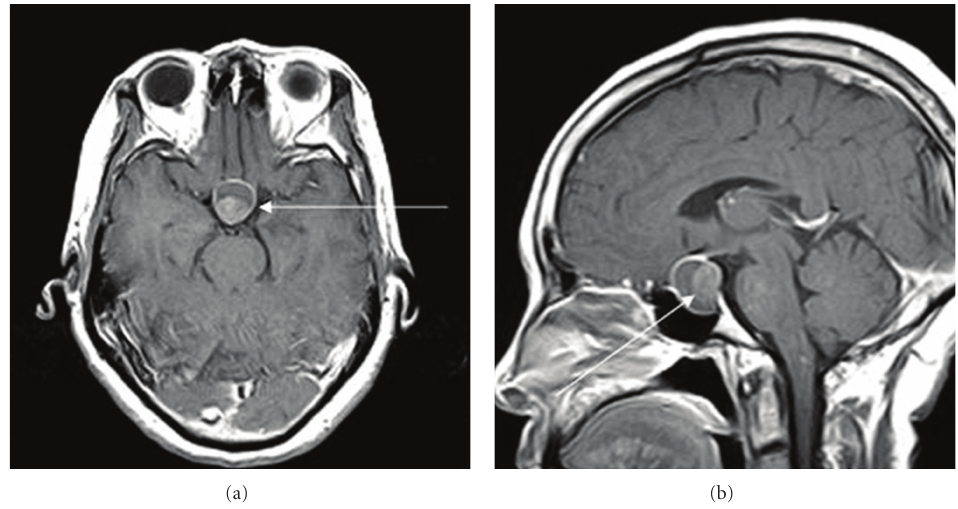
Figure 1: Case 2: enhanced MRI T1-weighted images. Intracystic nodules with hyperintense signal on T1-weighted images in the posterior RCC (arrow).